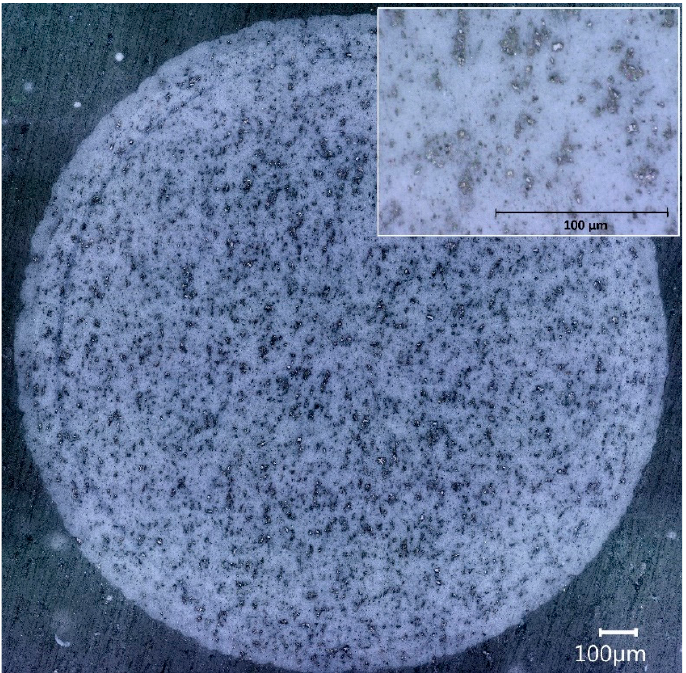
Figure 5. Microscopic image of the microstructure of the used PET-G filament containing metal oxides.